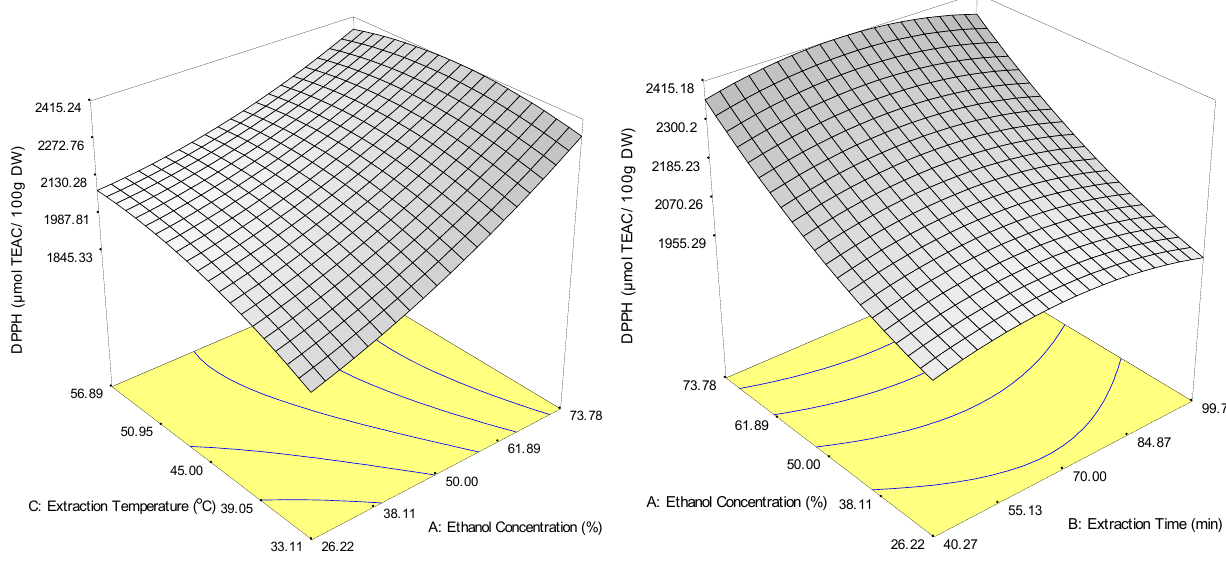
Figure 3. Response surface plot for the effects of extraction conditions on the recovery of DPPH of ethanol extracts from M. citrifolia powder by solvent